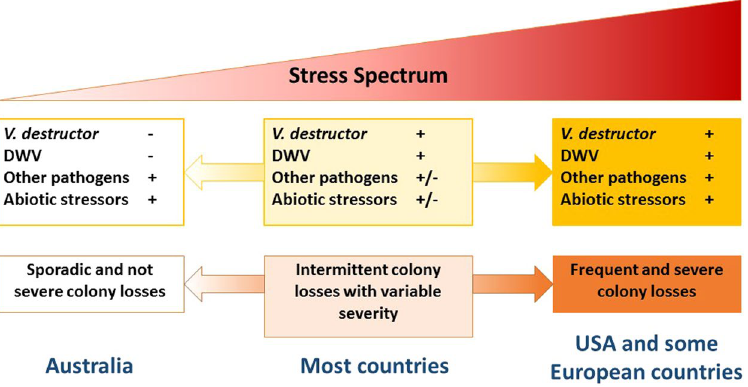
Figure 4. A conceptualization of A. mellifera colony stress as a spectrum with the current Australian situation being at one end and experiencing only sporadic colony losses and the increased colony losses of the USA and parts of Europe at the right-most extent of the spectrum. We hypothesize that a key underlying driver creating this spectrum may be V. destructor and DWV acting as co-pathogens, and interacting with other pathogens and abiotic stressors. Most countries are situated in the middle, with variable occurrence and severity of colony